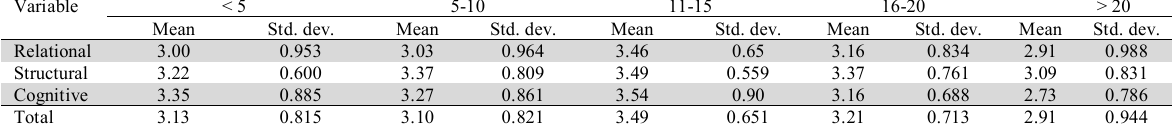
The summary of mean and standard deviation of social capital and job experience Variable < 5 5-10 11-15 16-20 > 20 Mean Std. dev. Relational